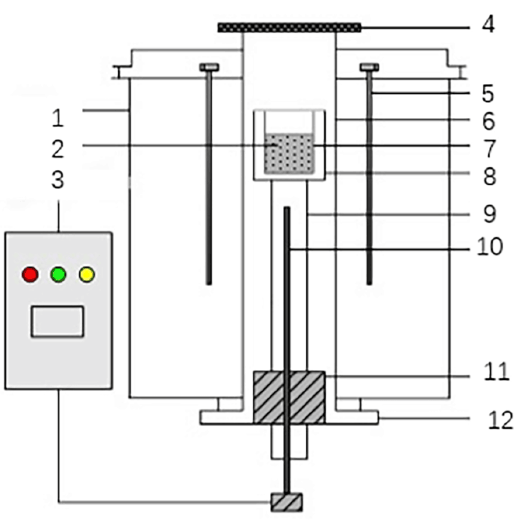
Figure 2. A diagram of the experiment device. 1: Furnace shell, 2: Melt and slag, 3: